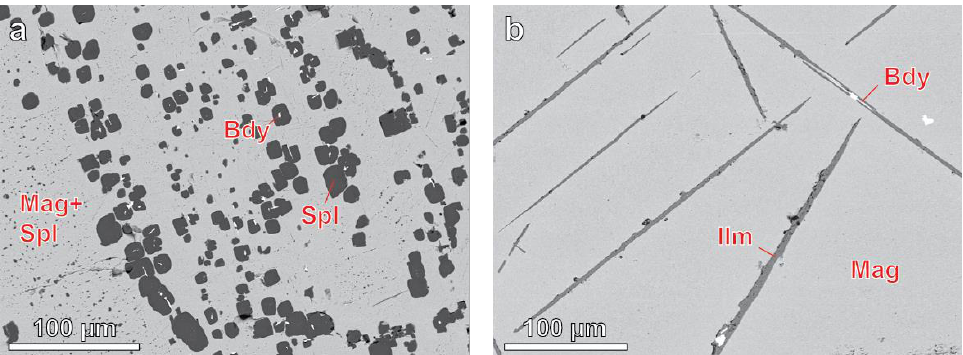
Figure 13. Particles of baddeleyite within exsolution inclusions of spinel and ilmenite in magnetite from calcite-magnetite-apatite phoscorite 956/138.9 ( a ) and magnetite-forsterite phoscorite 987/2.1 ( b ). Mineral abbreviations are in Section 2.